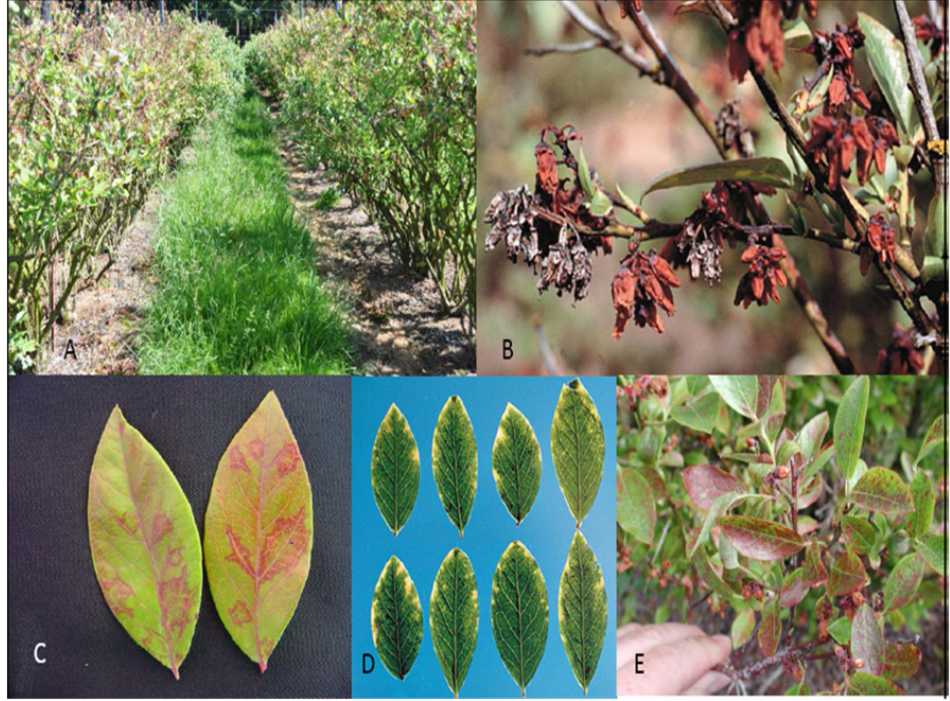
Figure 4. Blueberry scorch virus symptoms: ( A ) Blueberry cv. ‘Elliott’, necrotic flowers and leaves in foreground, healthy bushes in background; ( B ) Blueberry cv. ‘Berkeley’ showing flower necrosis and retention, silvery flowers are from previous year, brown flowers from current year; ( C ) Line and oakleaf patterns; ( D ) Chlorotic leaf margins in cv. ‘Stanley’; E. Leaf reddening in cv. ‘Concord’.